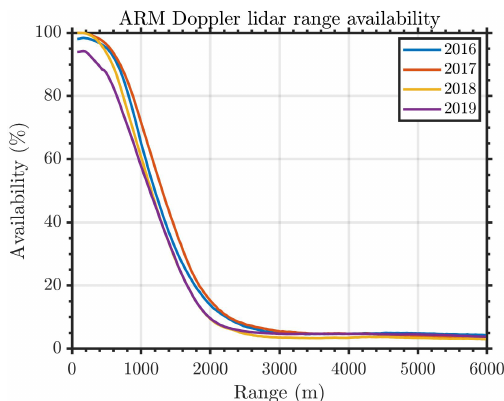
Figure A1. ARM SGP C1 Doppler lidar range availability versus range from vertical stares from 2016 to 2019 after SNR filtering (threshold of 1.008dB).